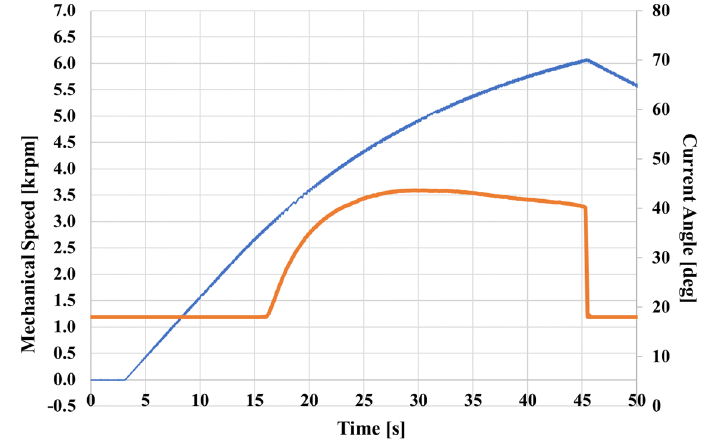
Figure 15. Experimental results of outer voltage method of [17] with proposed FW control: current angle (orange solid line) and angular mechanical speed (blue solid line) .